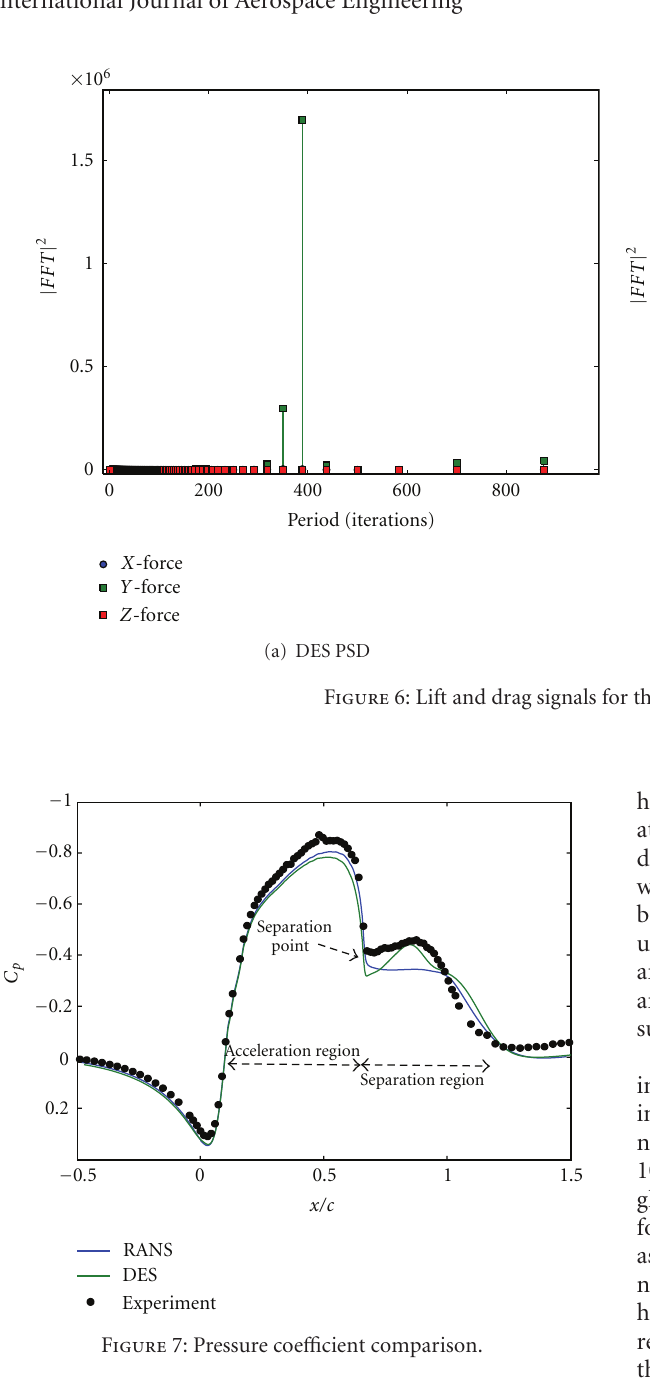
in Figure 4. The spanwise direction was meshed using 49 points with uniform spacing and corresponds to roughly two boundary layer thicknesses based on the